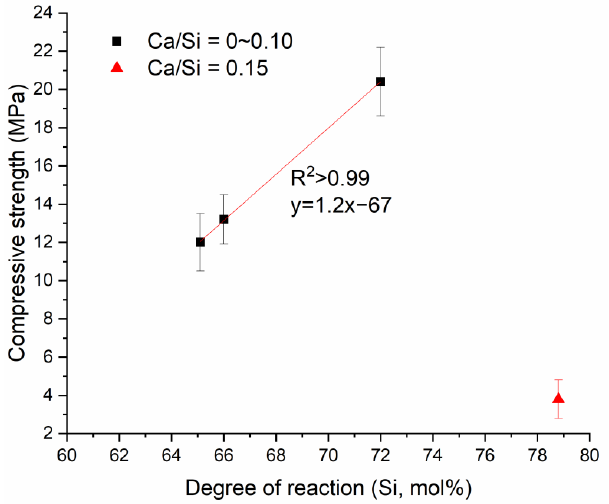
Figure 8. Compressive strength versus degree of reaction for geopolymers with different Ca/Si ratios at 7 days.